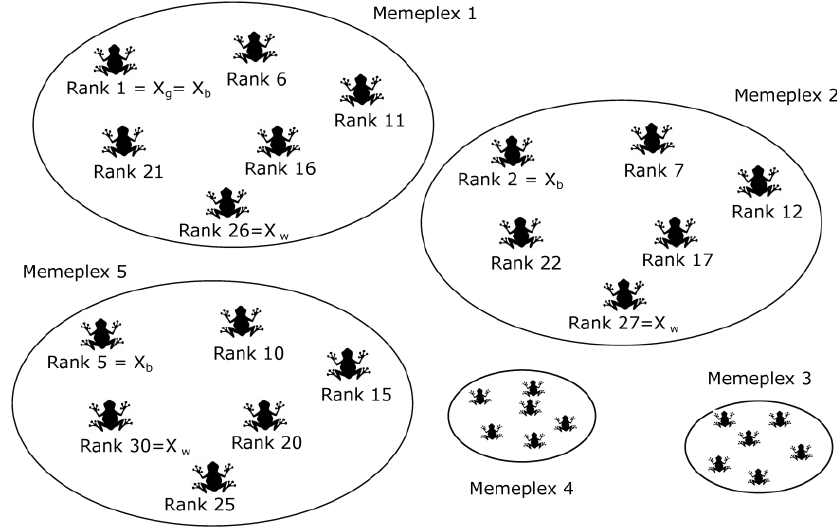
Figure 2. Distribution of frogs in memeplexes according to their cost function.